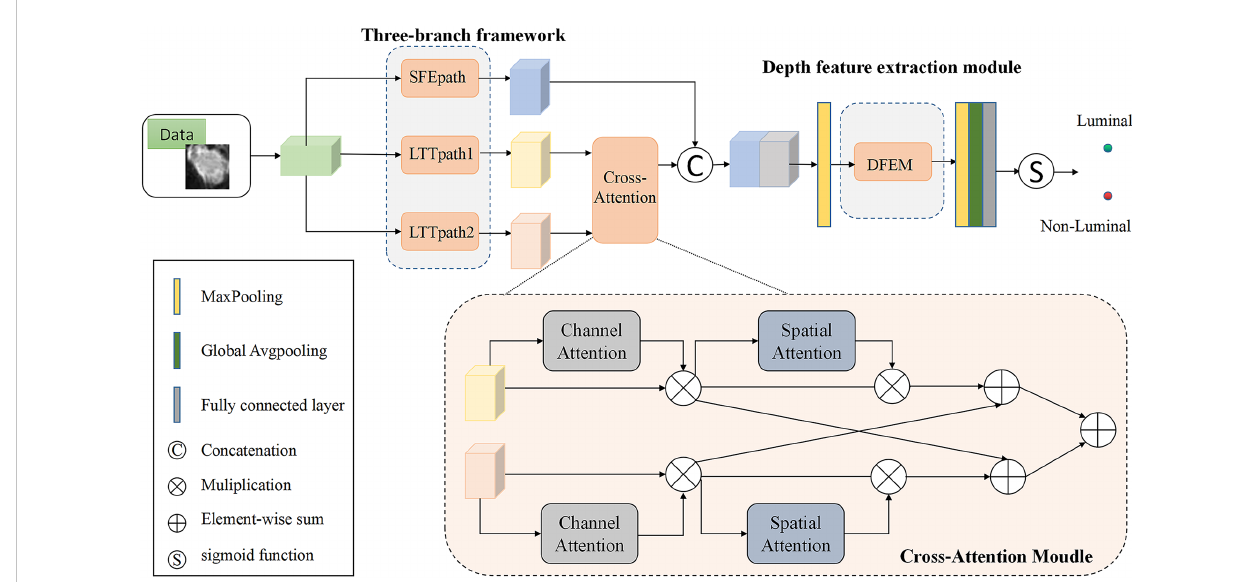
FIGURE 2 Structure of the model (SFEpath, Shallow feature extraction path; LTTpath, Locating the tumor path; DFEM, Depth Feature extraction